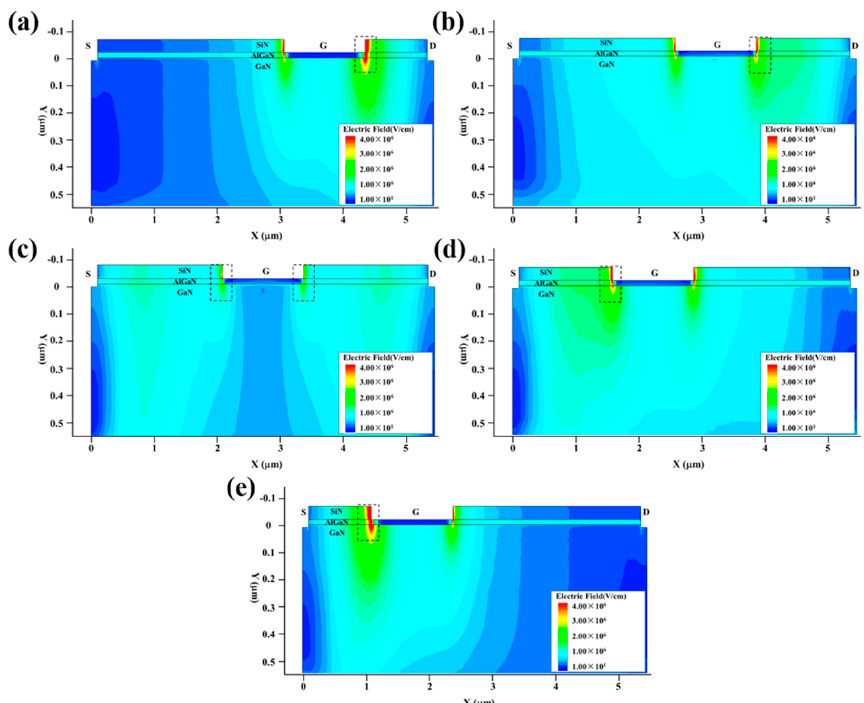
Figure 8. The electric field distribution of the GaN HEMT at the moment of burnout for different device structures: ( a ) Lgs:Lgd = 3:1; ( b ) Lgs:Lgd = 2.5:1.5; ( c ) Lgs:Lgd = 2:2; ( d ) Lgs:Lgd = 1.5:2.5; ( e ) Lgs:Lgd = 1:3.